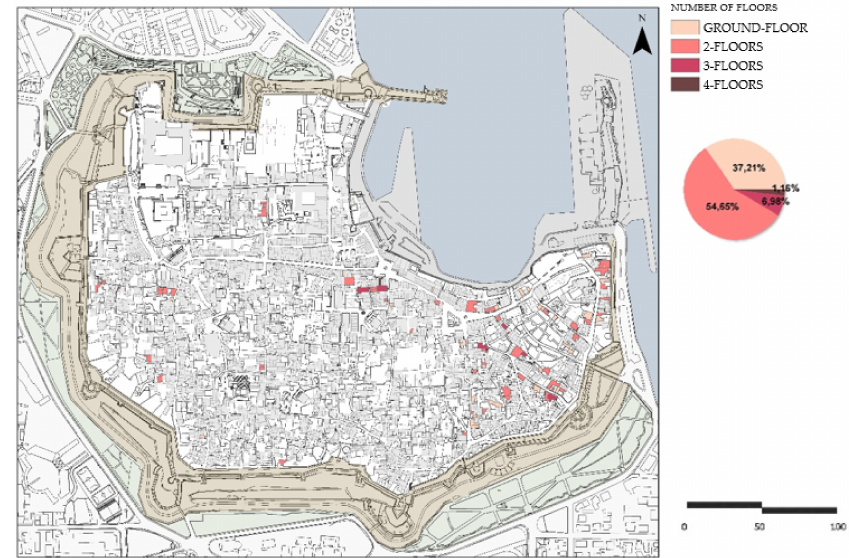
Figure 17. Number of floors (ground floor, 1st/2nd/3rd/4th floor).